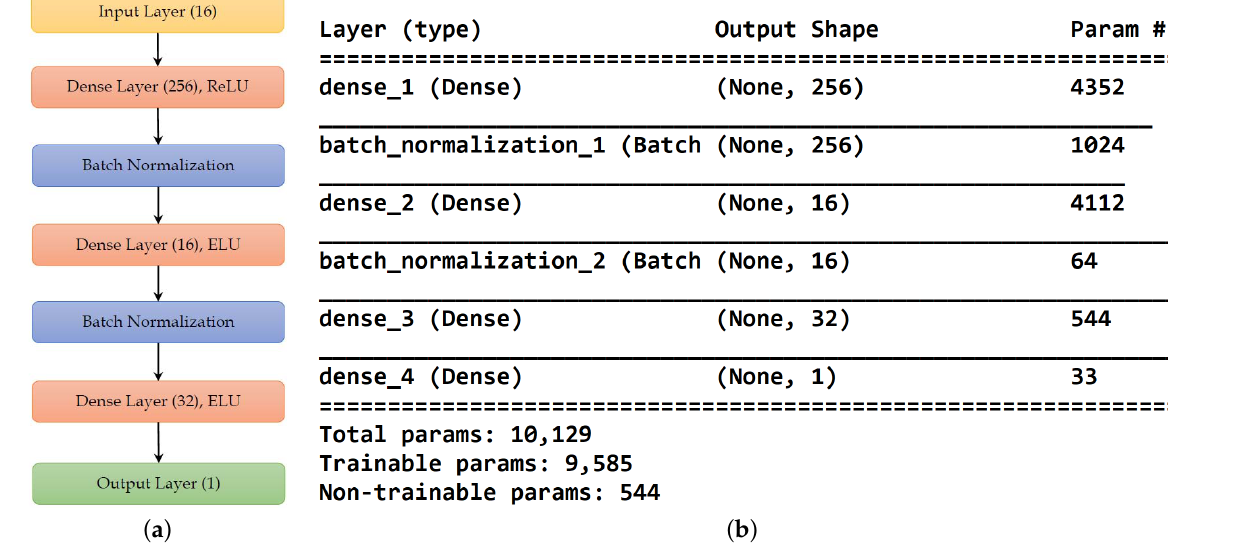
Figure 2. The Architecture for our model. In ( a ) overview of the architecture, we show an overview of the architecture where each layer name is followed by an integer value in brackets showing the number of neurons in the layer followed by an activation functions. In ( b ) in-depth illustration of the architecture, we plot the detailed architecture with the tensor shape and the total parameters at each